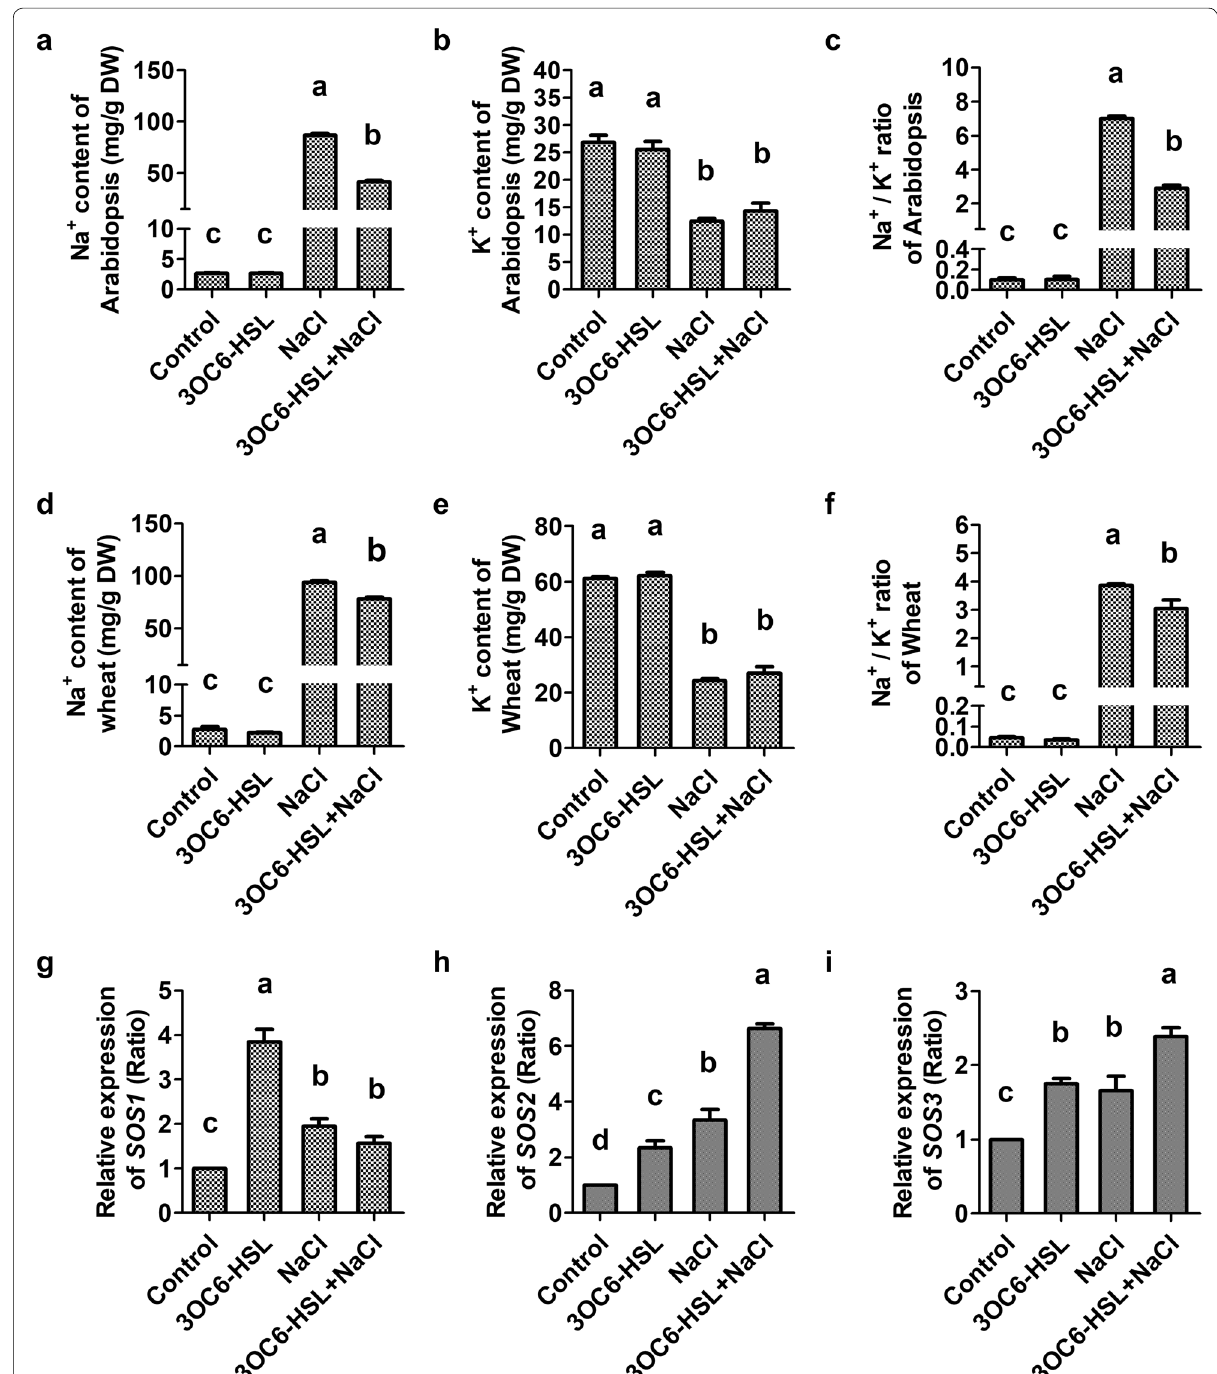
Fig. 4 Effect of 3OC6‑HSL on cellular ionic homeostasis in Arabidopsis and wheat. 2‑week‑old seedlings were treated with 1 μM 3OC6‑HSL or/ and 150 mM NaCl as indications. The contents of Na + and K + were measured and Na + /K + ratio were calculated after treatment for 14 days in Arabidopsis ( a – c ) and 10 days in wheat ( d – f ). 20‑day‑old seedlings were treated with 1 μM 3OC6‑HSL or/and 150 mM NaCl as indications. The relative gene expression of SOS1 ( g ), SOS2 ( h ) and SOS3 ( i ) were measured by qRT‑PCR after treatment for 6 h in Arabidopsis. Values are mean of three independent experiments. Different letters indicate statistically significant differences ( P < 0.05, Duncan’s